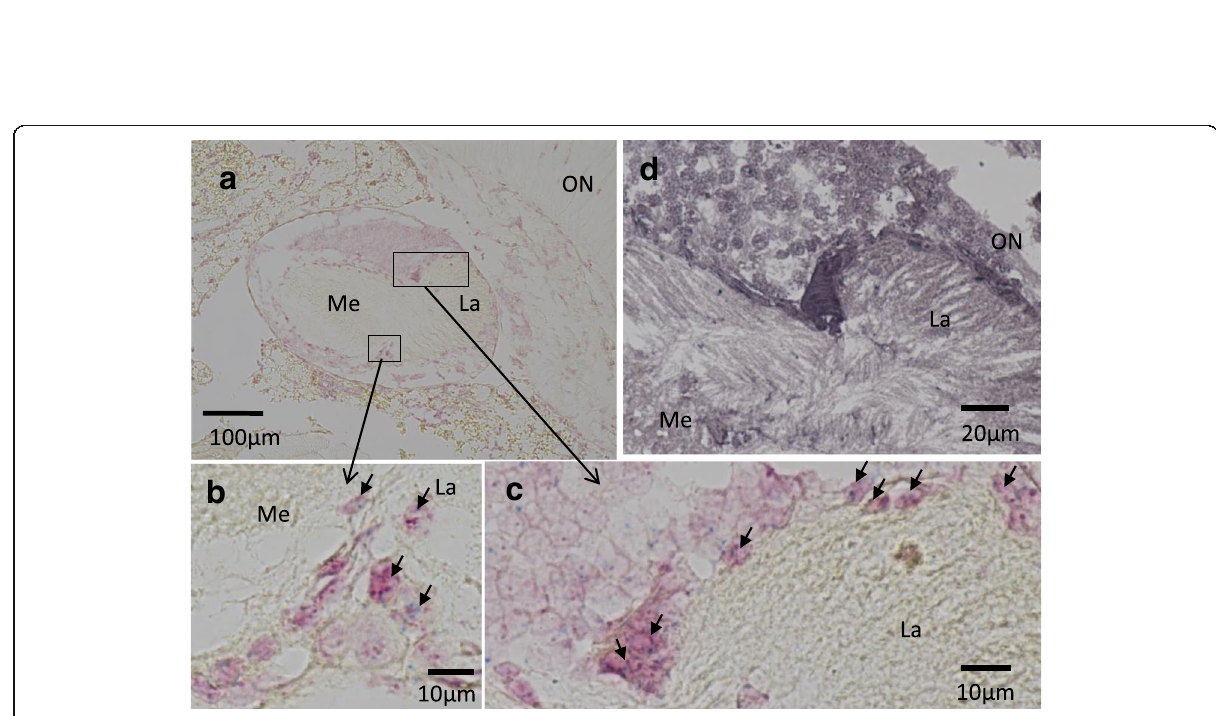
Fig. 5 Expression of Gb ’ per , Gb ’ cry2 , and Gb ’ c-fosB in the optic lobe of the cricket Gryllus bimaculatus . a-c In situ hybridization of Gb ’ per (red) and Gb ’ cry2 (blue) in the optic lobe sampled at ZT18. b and c shows magnification of areas near outer chiasma indicated in a . Short arrows indicate the cells coexpressing Gb ’ per and Gb ’ cry2 . d In situ PCR of Gb ’ c-fosB in the optic lobe after 1 h light exposure at ZT20. Gb ’ c-fosB was strongly expressed in the cells near outer chiasma and along the outer surface of lamina. For further explanations see